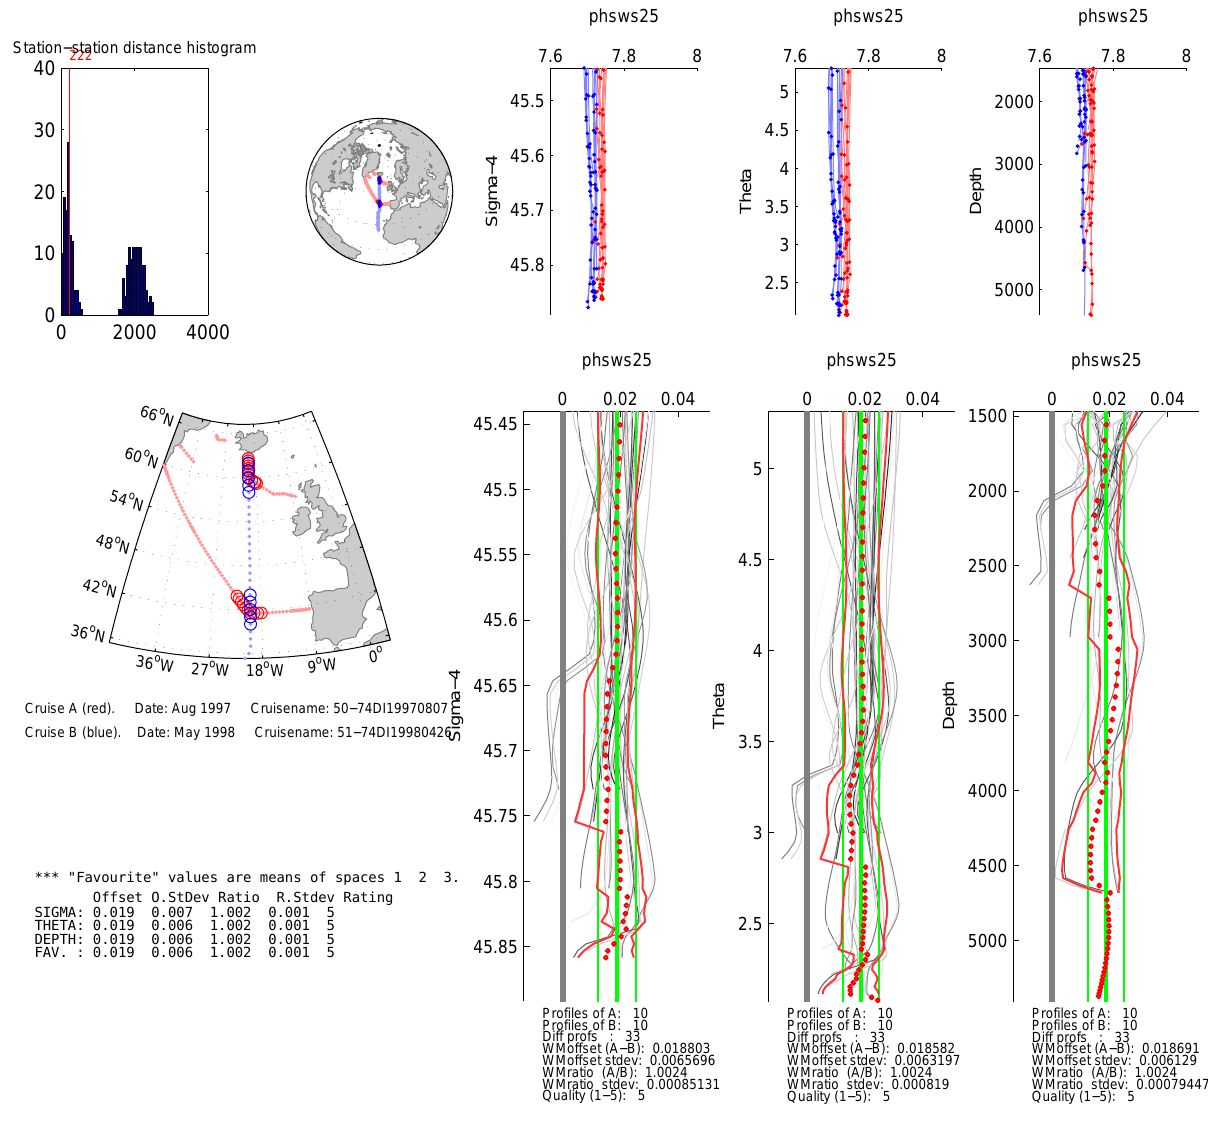
Figure 3. Crossover made with cnaX